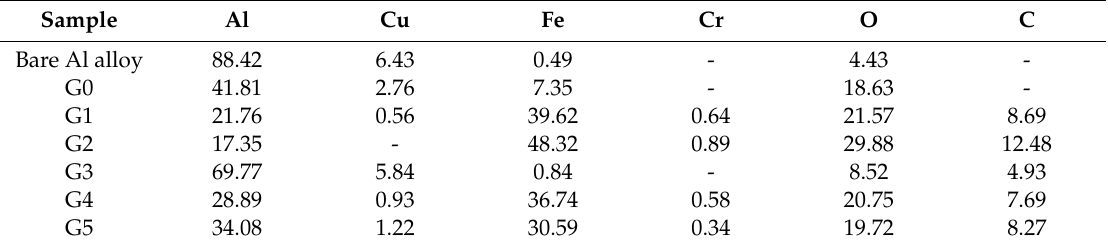
Figure 14. SEM morphologies of the wear track of ( a ) the substrate and ( b – g ) the coatings with different concentration graphene, ( b ) G0, ( c ) G1, ( d ) G2, ( e ) G3, ( f ) G4, ( g ) G5, (the inset figure in each image is the corresponding magnified SEM image of the local wear track). Table 4. Elemental compositions of the substrate and the coated samples after the wear test determined from EDS